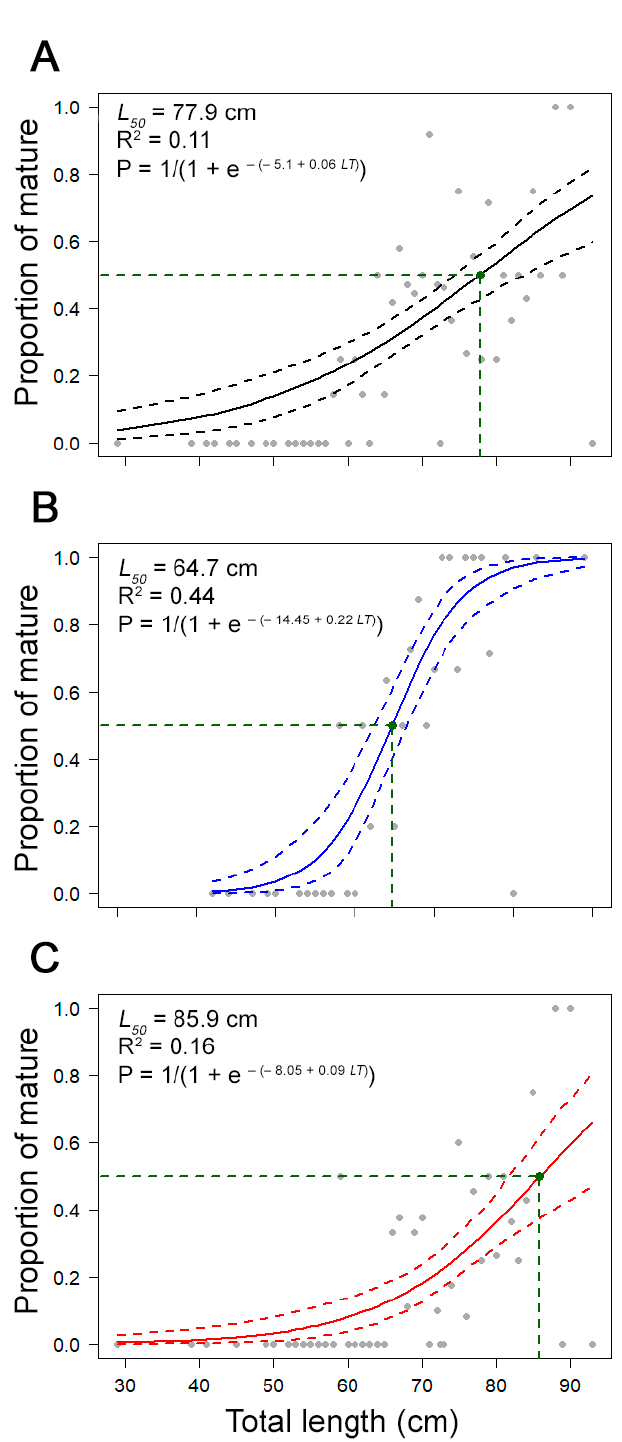
Figure 8. Maturity ogives for ( A ) combined sexes, ( B ) males, and ( C ) females of the thornback ray Raja clavata in the Azores. The solid curve represents the estimated logistic curve (±0.95 confidence intervals), and the dots represent the observed proportion of mature fish. Data from the scientific surveys.